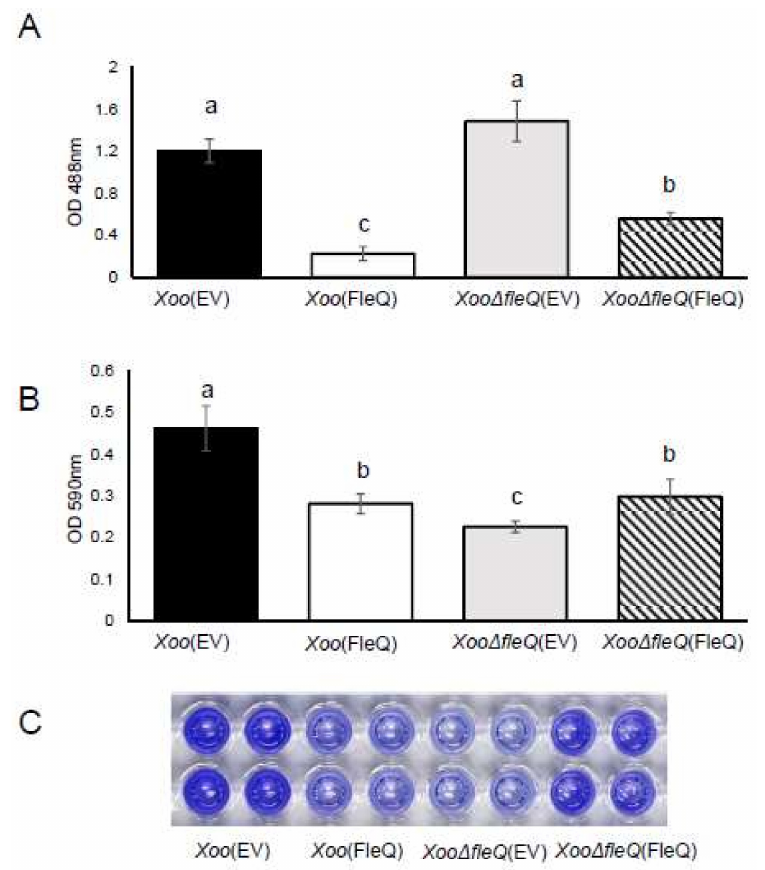
Figure 3. Extracellular polysaccharide (EPS) production and biofilm formation in Xoo strains. ( A ) After Xoo strains were cultured in peptone sucrose broth for 1 day and in XOM2 for 4 days, EPS was quantified by a phenol-sulfuric acid method at 488 nm. Bars represent the mean of five biological replicates with the standard deviation. ( B ) Biofilm formation from Xoo strains was determined by the PVC plate assay. Bars indicate the means of 12 biological replicates with the standard deviation. Different letters on the bars indicate statistically significant differences in average values by one-way ANOVA ( p < 0.05). ( C ) The photograph of stained cells resolved in 95% EtOH solution was taken at 7 days after incubation in XOM2. OD = optical